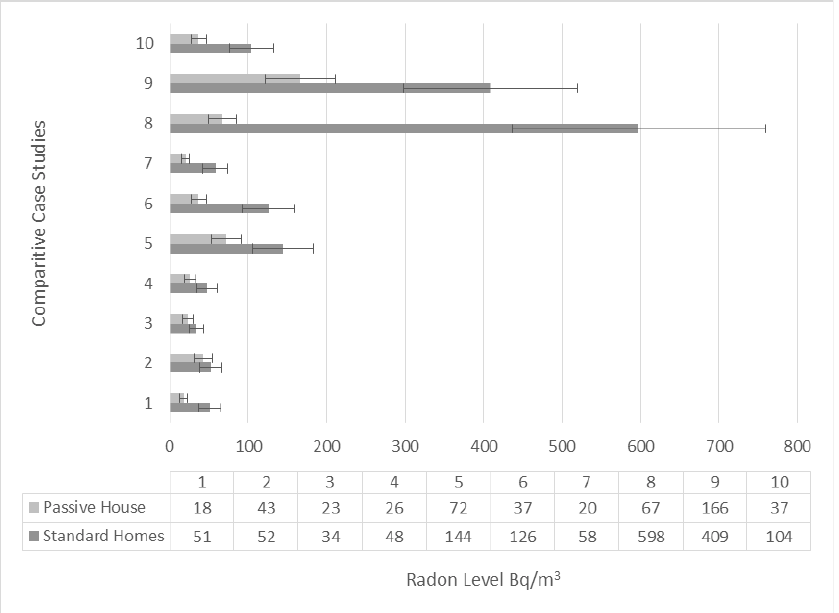
Figure 5. Direct comparative case studies.